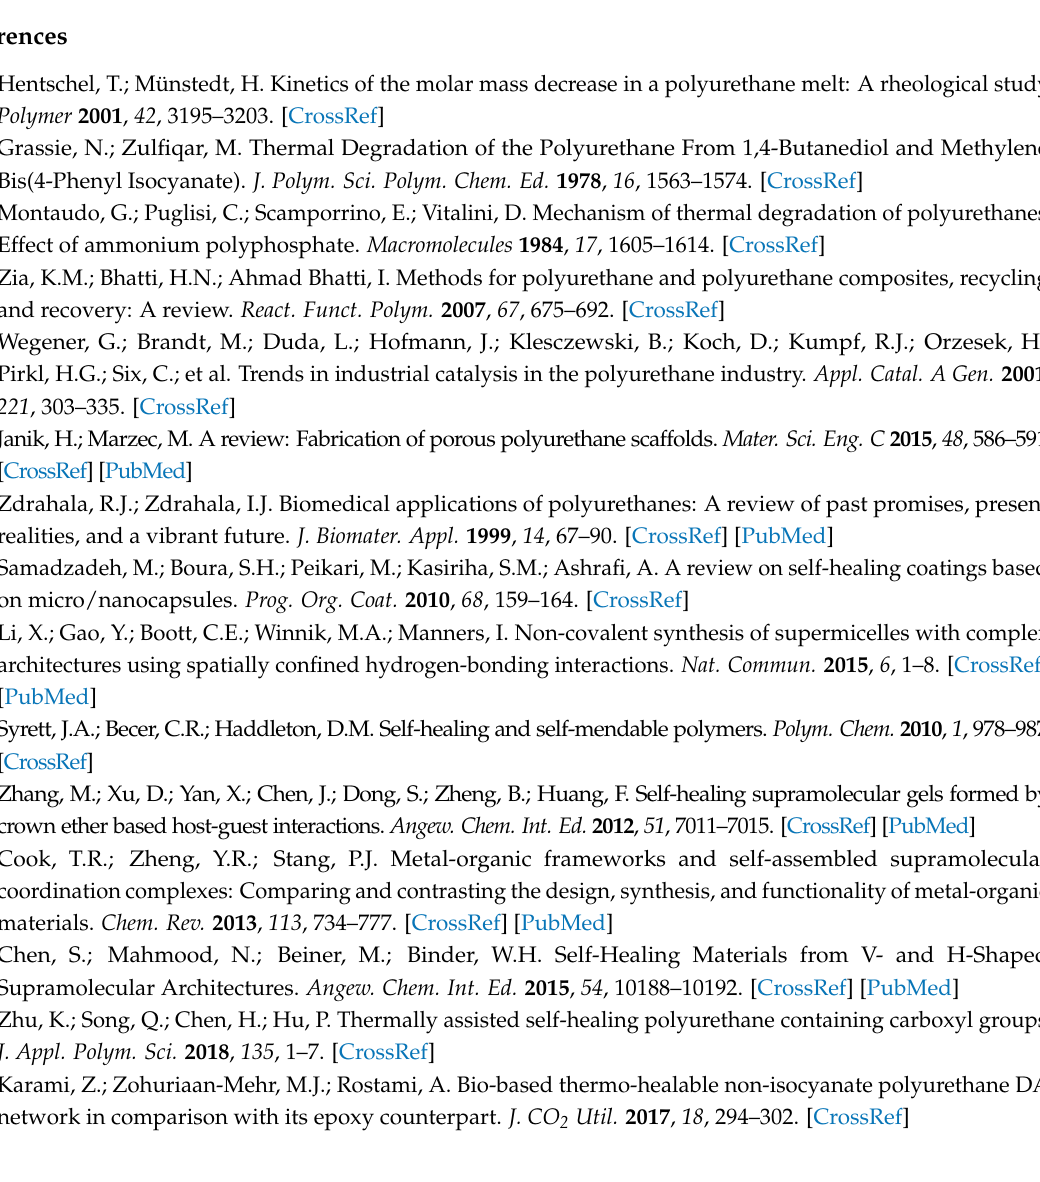
Figure S4: TGA thermograms of AMD based PUEs: ( A ) AMD2 based PUEs; and ( B ) AMD3 based PUEs, Figure S5: Dynamic mechanical analysis of AMD based PUEs: ( A ) Storage moduli of AMD2 based PUEs; ( B ) Storage moduli of AMD3 based PUEs; ( C ) Tan Delta of AMD2 based PUEs; and ( D ) Tan Delta of AMD3 based PUEs, Figure S6: DSC thermograms of AMD based PUEs: ( A ) AMD2 based PUEs; and ( B ) AMD3 based PUEs, Figure S7: SAXS data (absolute intensity profiles) of the synthesized PUEs, Figure S8: AFM images of synthesized PUEs, Figure S9: Representative stress relaxation behaviors for the AMD2 based PUEs, Figure S10: Representative stress relaxation behaviors for the synthesized AMD3 based PUEs, Figure S11: Stress–strain curves of the synthesized PUEs before and after healing at 130 ◦ C for 30 min: ( A ) AMD2 based PUEs; ( B ) AMD3 based PUEs; ( C ) Healed AMD2 based PUEs; ( D ) Healed AMD3 based PUEs; ( E ) Tensile stress of synthesized PUEs; and ( F ) Toughness of synthesized PUEs, Figure S12: Images of self-healing test for AMD2-20, Figure S13: Stress–strain curves of the AMD3-30 after repeated healing at 130 ◦ C for 30 min, Figure S14: Stress–strain curves of the adhered specimens of different PUEs after healing at 130 ◦ C for 30 min, Figure S15: Flow curves of AMD2 based PUEs at different temperatures, Figure S16: Flow curves of AMD3 based PUEs at different